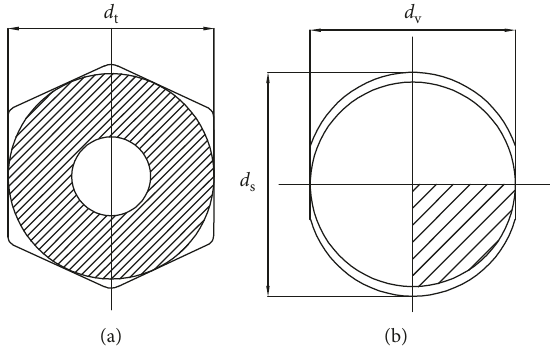
Figure 4: Diagrams showing the cross section of (a) anchorage nut and (b) steel